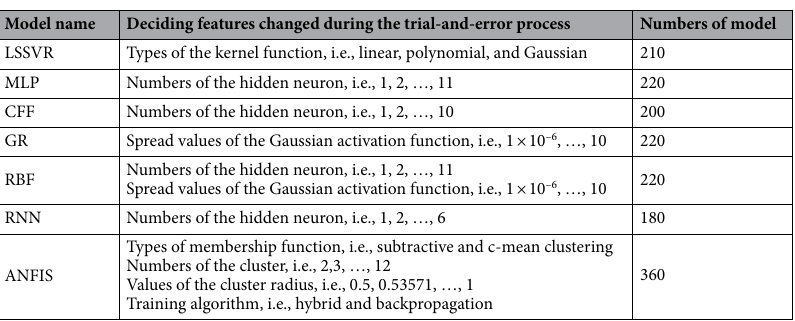
Table 3. The name and range of deciding features of each intelligent estimator during the trial-and-error